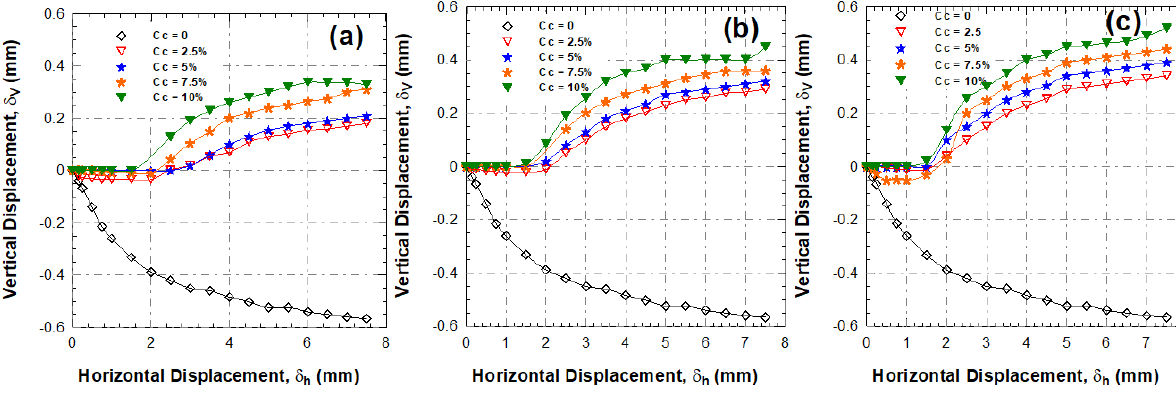
Figure 10: Influence of curing time on deformability of cemented sand ( σn = 100 kPa), (a) after 7 days, (b) 14 days, (c) 28